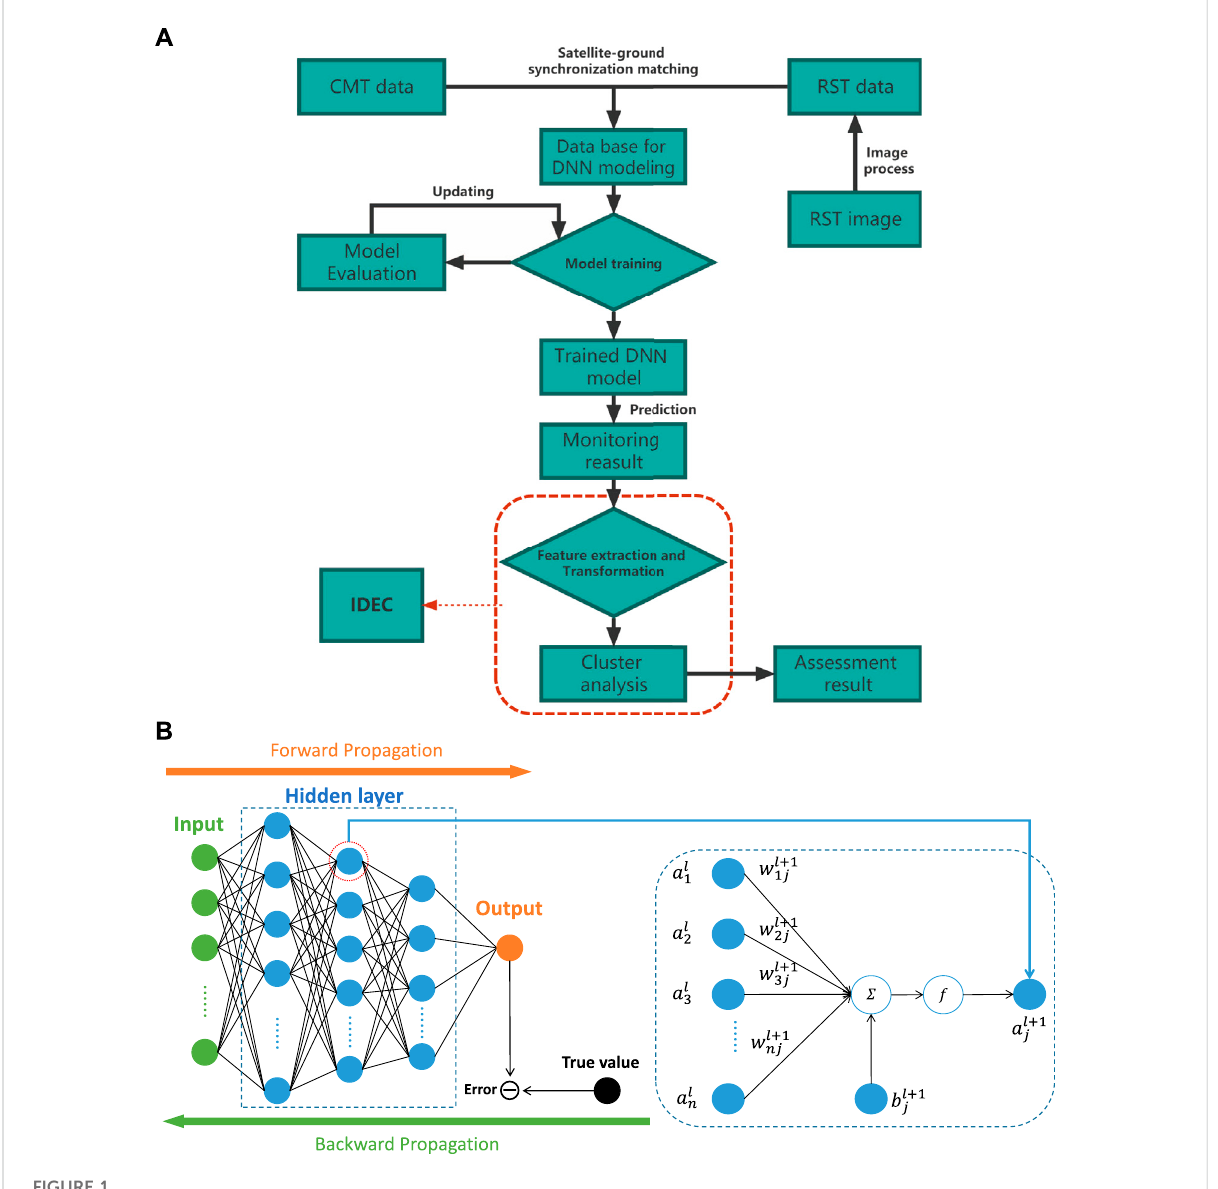
FIGURE 1 Schematic illustration of (A) the novel framework and (B) the architecture of